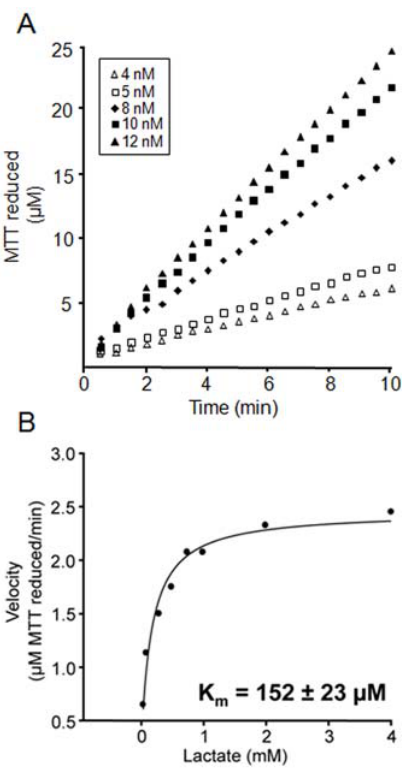
Figure 5. Kinetic analysis of LctD-his 6 . LctD-his 6 was incubated with L-lactate and enzymatic activity assessed by monitoring reduction of MTT as described [15,16,17]. (A) Enzymatic activity was assessed over time for multiple LctD-his 6 concentrations (4, 5, 8, 10, and 12 nM) in the presence of saturating substrate concentrations. For K m calculations, 8 nM LctD-his 6 was used. Representative data are shown. (B) The LctD- his 6 K m for lactate was calculated as 152 6 23 m M (average 6 standard deviation) by averaging values from quadruplicate experiments. Representative data are shown.